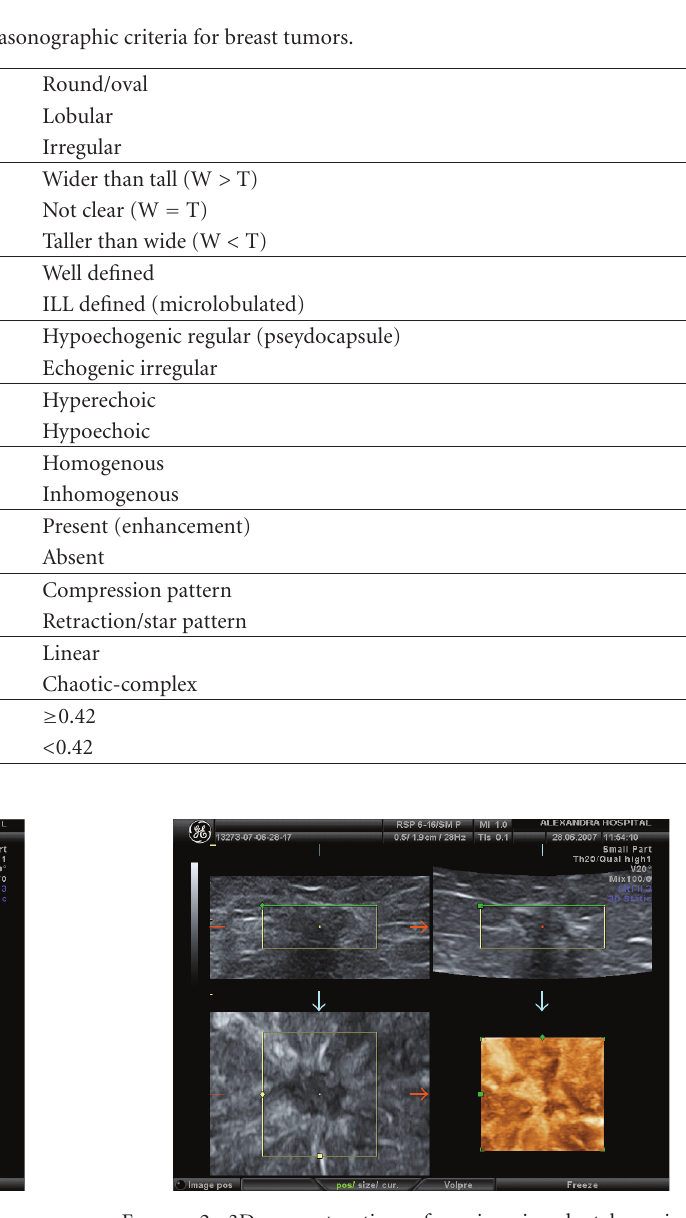
Figure 2: 3D reconstruction of an invasive ductal carcinoma angulated with inhomogenous echotexture and retraction